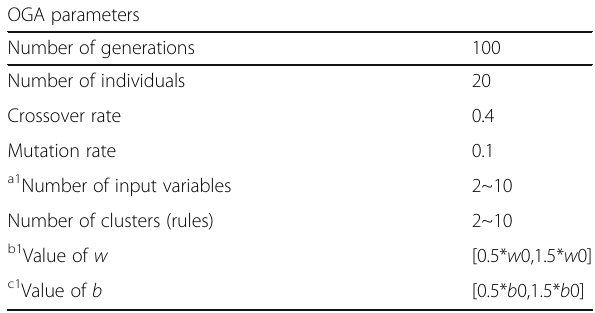
Table 1 List of the parameter of the OGA OGA